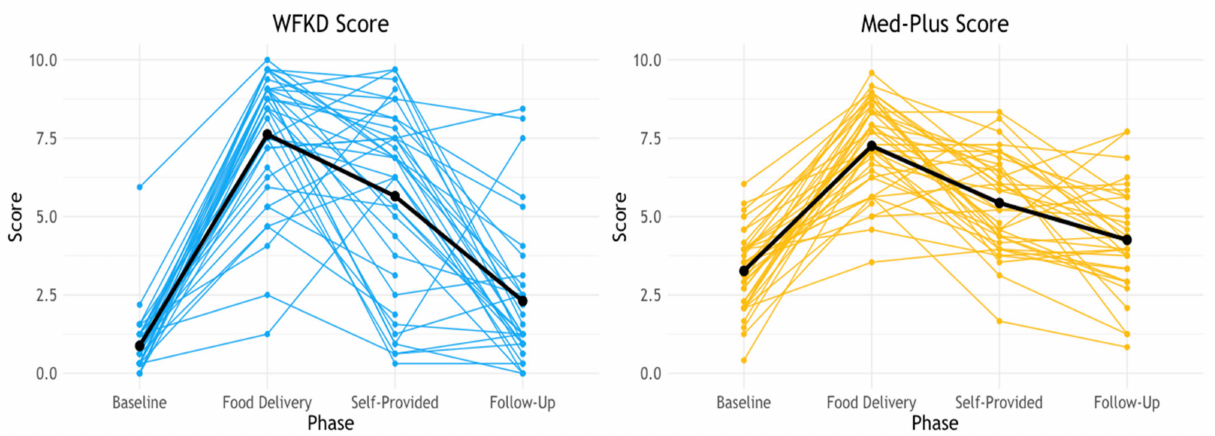
Figure 2. Individual participant change in diet adherence from baseline, food delivery, self-provided, and 12 weeks postintervention (follow-up). Solid black line represents the mean. While 23/36 (64%) participants received food deliveries during both diet phases, 13/36 (36%) participants only received food deliveries during their first diet phase due to disruptions in the study protocol caused by